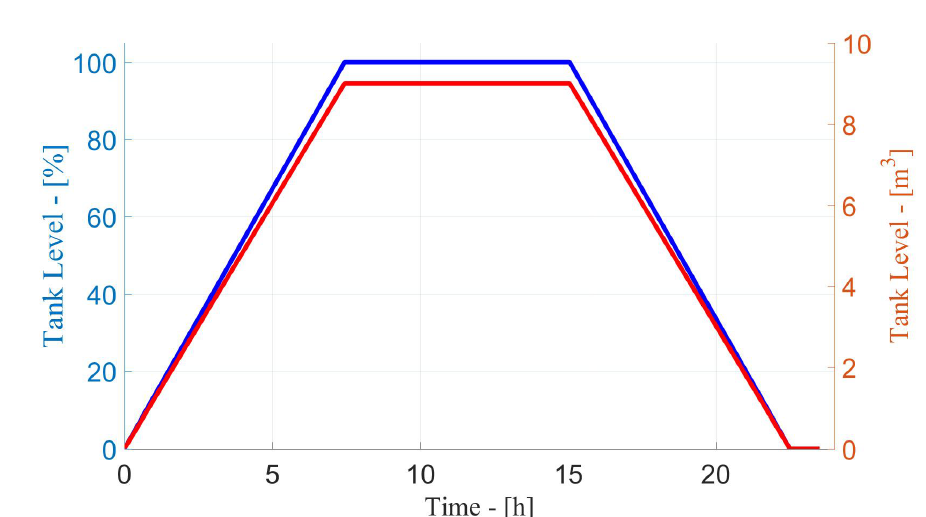
Figure 7. Hydrogen storage tank model. Charging - discharging hydrogen tank with a constant flow rate of 20